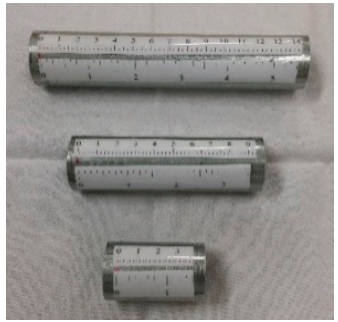
Figure 9. Image plane locators.